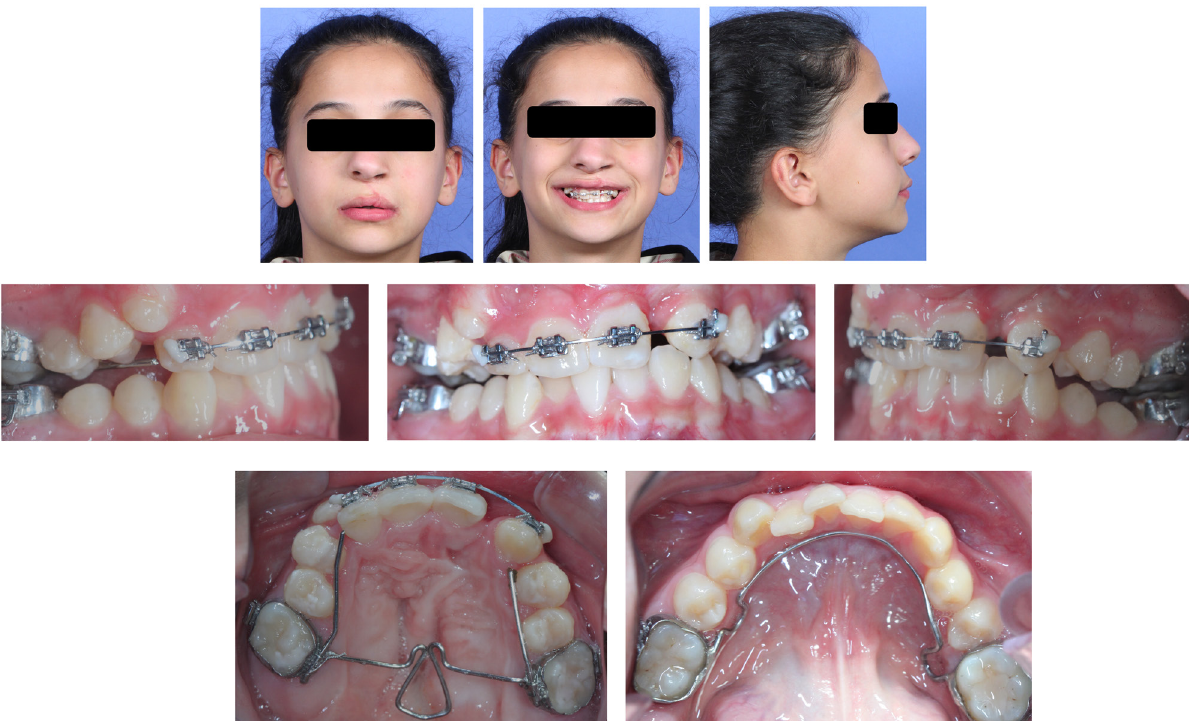
Figure 5. Appearance of anterior brackets and custom-made transpalatal arch applied after maxillary expansion procedure in the maxilla and lingual arch in the